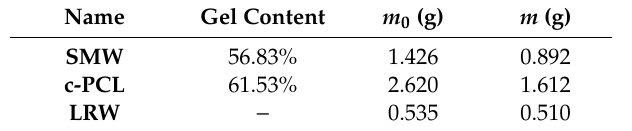
Table 2. The Gel Contents of SMW, crosslinking-PCL (c-PCL), and The Extractive Content of Balsa